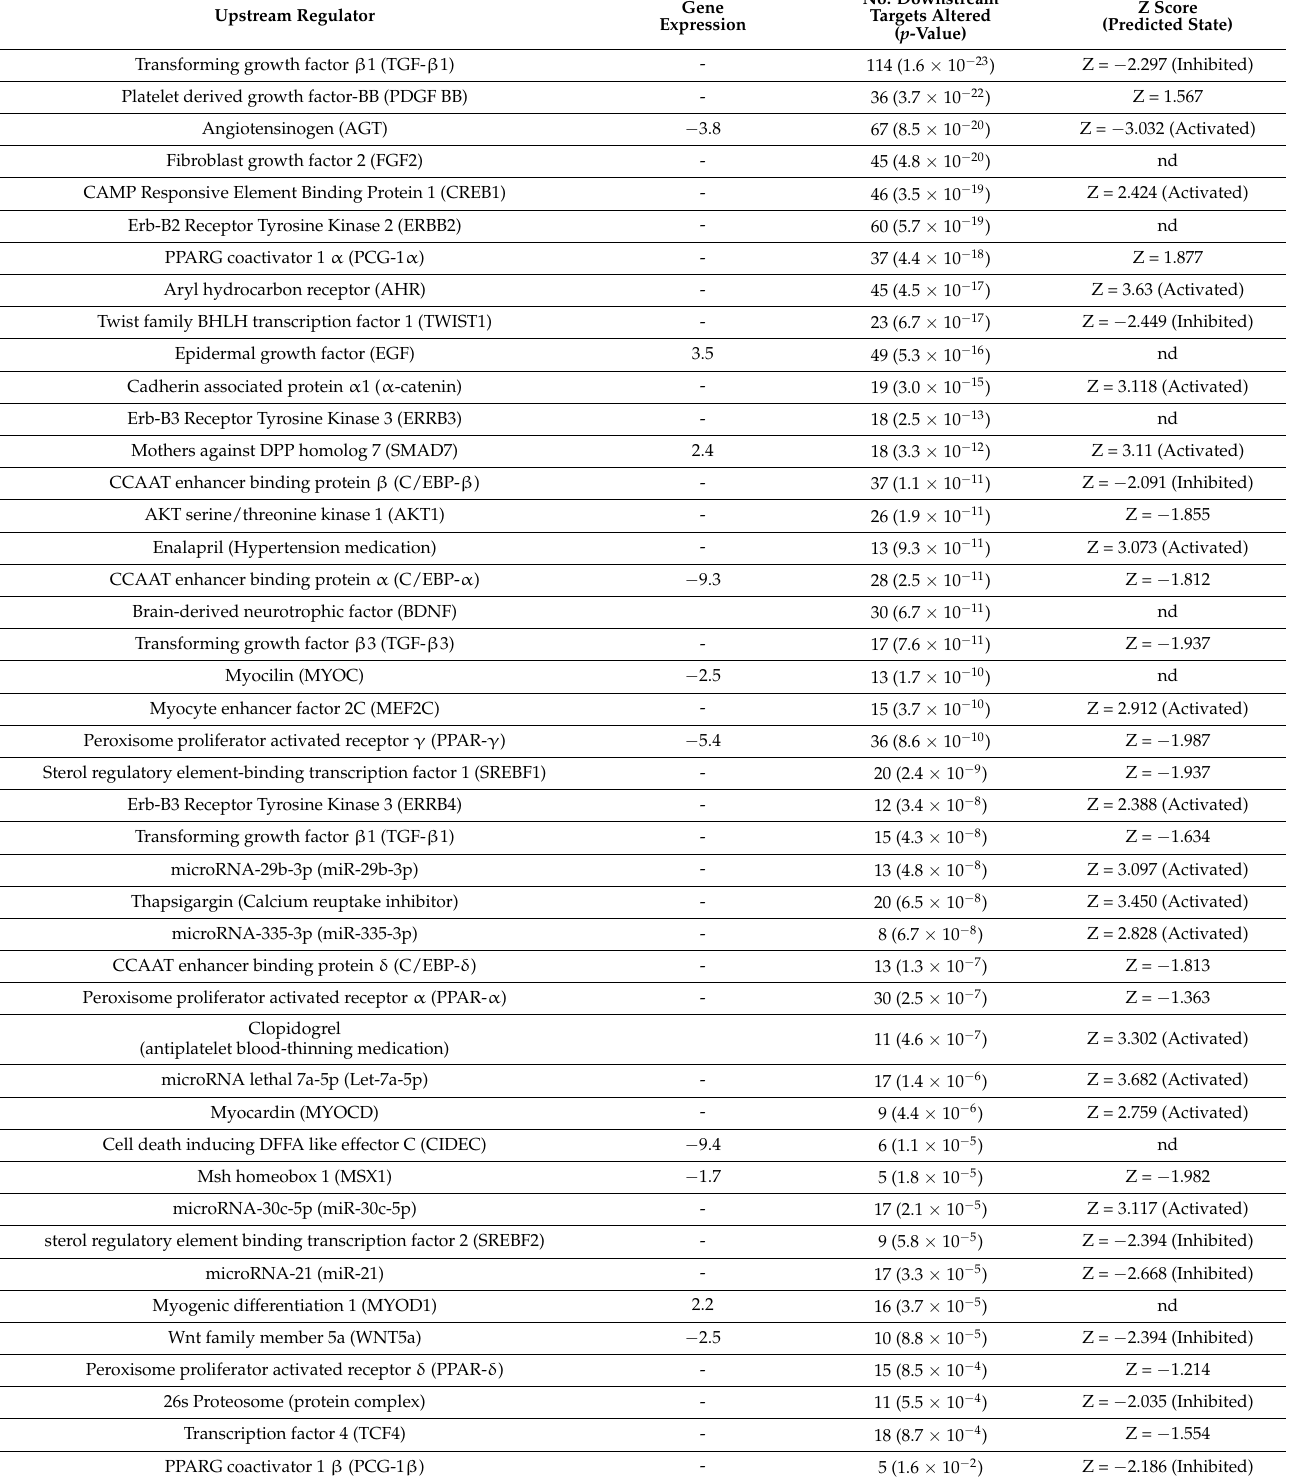
Table 3. Predicted upstream regulators for GGF2-altered